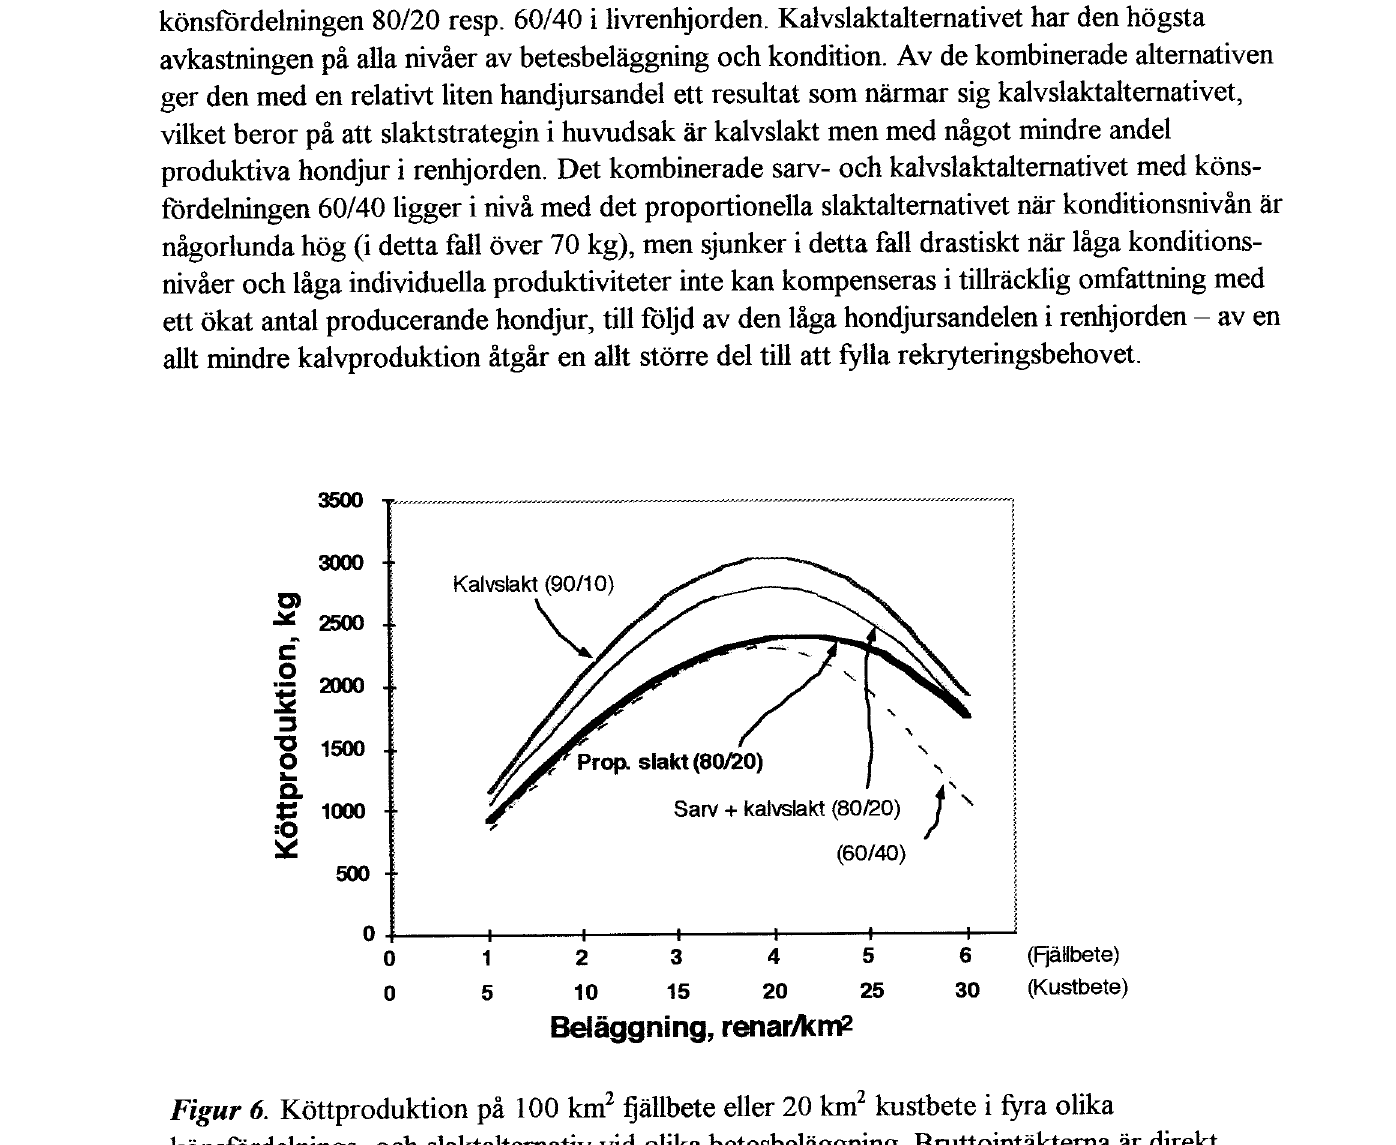
Figur 6. Köttproduktion på 100 km 2 fjållbete eller 20 km 2 kustbete i fyra olika könsfördelnings- och slaktalternativ vid olika betesbelåggning. Bruttointäktema år direkt proportionella till köttproduktionen, och driftskostnaderna (ej med i figuren) kan antas vara samma som i figur 4 for alla alternativen vid samma belåggning. Vid produktionsmaximum